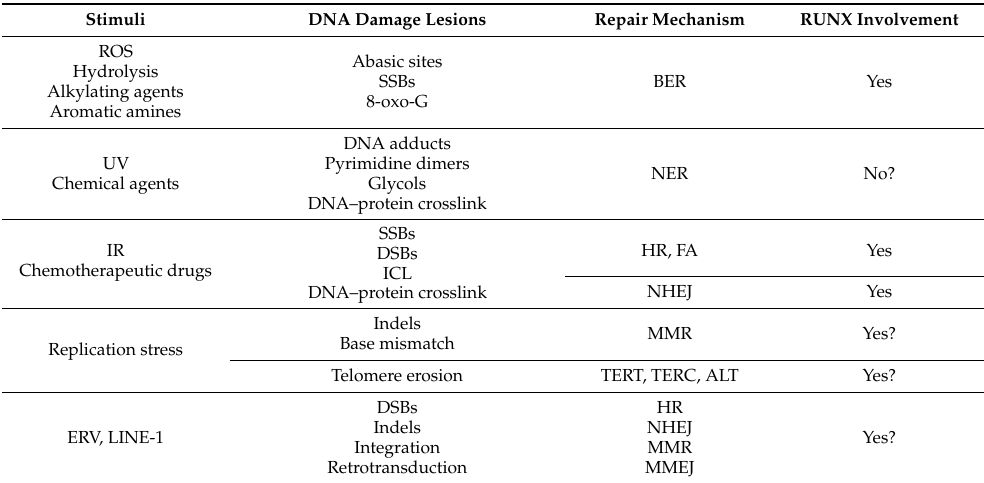
Table 1. Involvement of the RUNX family in DNA repair pathways.